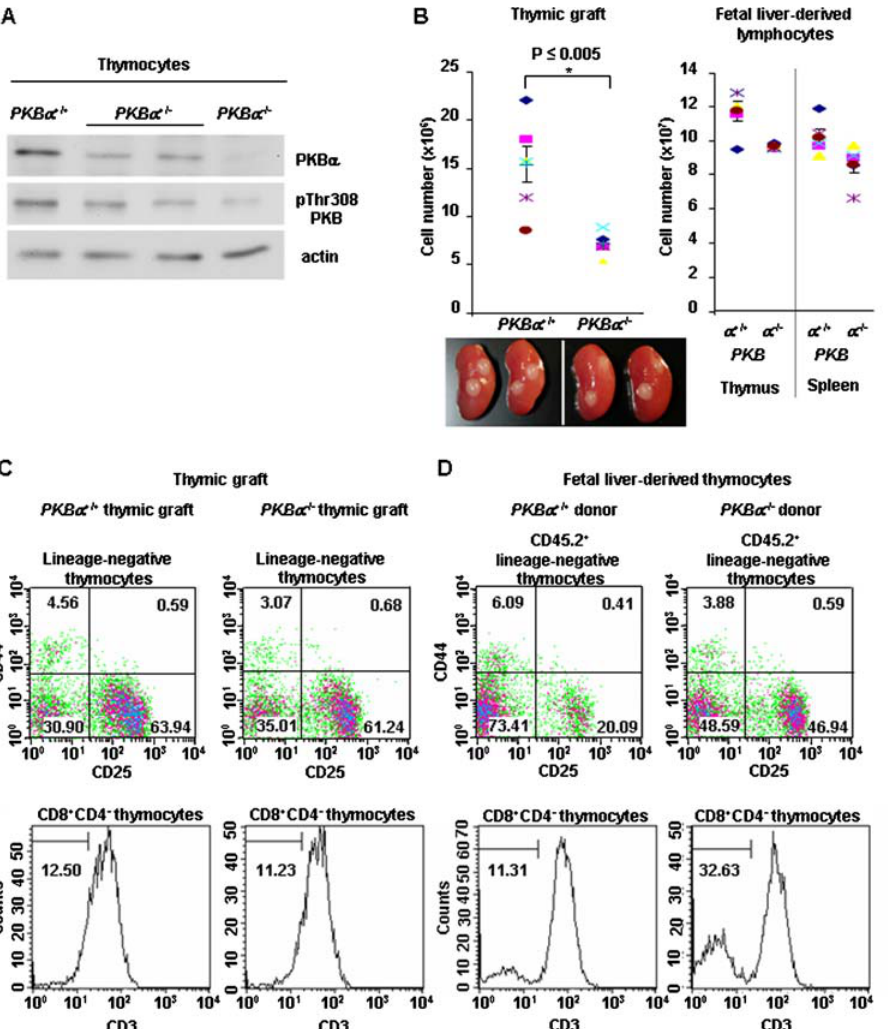
Figure 4. The accumulation of early thymocytes is due to PKB a deficiency in the lymphoid compartment. A: Western-blot analysis of 50 m g protein extracts from PKB a + / + , PKB a + / 2 , and PKB a 2 / 2 isolated thymocytes using antibodies directed against either PKB a or phospho(Thr308)-PKB (PDK1 site). Actin was used as a loading control. B: Thymocytes were isolated from PKB a + / + and PKB a 2 / 2 thymic grafts and counted 4 weeks post grafting (left panel). Lymphocytes were isolated from thymus and spleen of lethally irradiated congenic recipient mice injected with either PKB a + / + or PKB a 2 / 2 fetal liver cells and counted 5 weeks post transplant (right panel). Error bars represent standard error of the mean; n $ 5. C–D: Flow cytometric analysis of lymphocytes. C: Host-derived thymocytes developed in the PKB a + / + or PKB a 2 / 2 fetal thymi grafted under the kidney capsule of wild-type mice were isolated 4 weeks post-grafting and stained with cell surface markers for identification of early thymocyte subsets. D: Thymocytes developed from PKB a + / + or PKB a 2 / 2 fetal liver-derived HSC in lethally-irradiated wild-type congenic mice were isolated 5 weeks after reconstitution and stained with cell surface markers for identification of early thymocyte subsets. Representative density plots and histograms are shown. n $ 5 (n=number of mice per genotype within the same